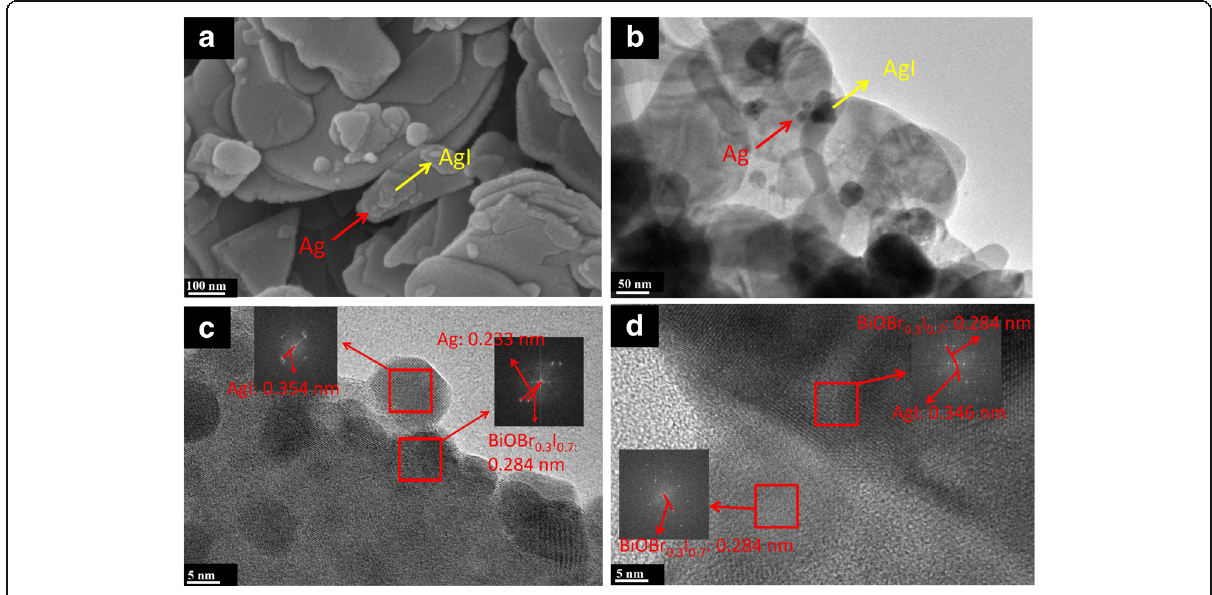
Fig. 2 SEM images of BBA-3( a ), TEM images of BBA-3 ( b ), HRTEM and FFT images of BAA-3 ( c ), and BiOBr 0.3 I 0.7 /AgI ( d )